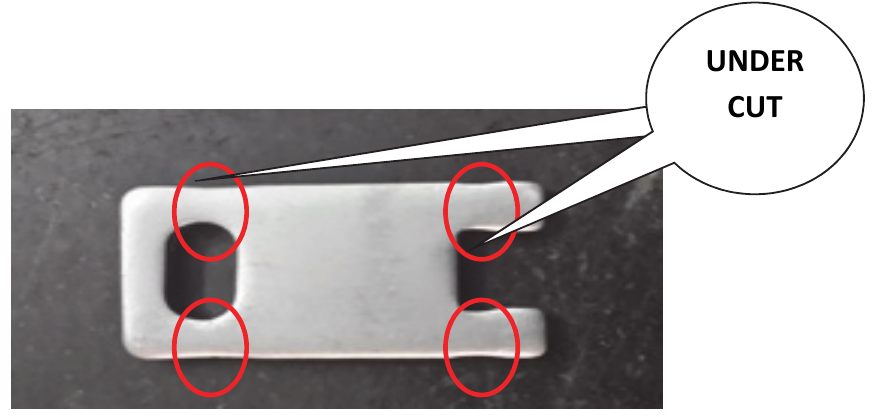
Fig. 4. Seat Slider Lock Nut